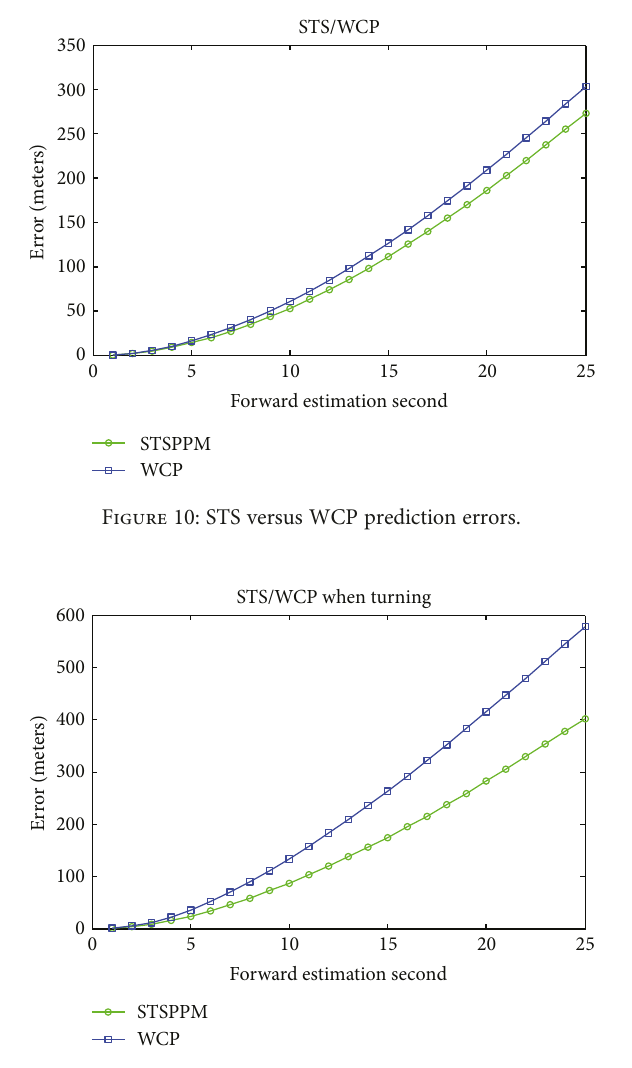
Figure 11: STS versus WCP prediction errors when turning.